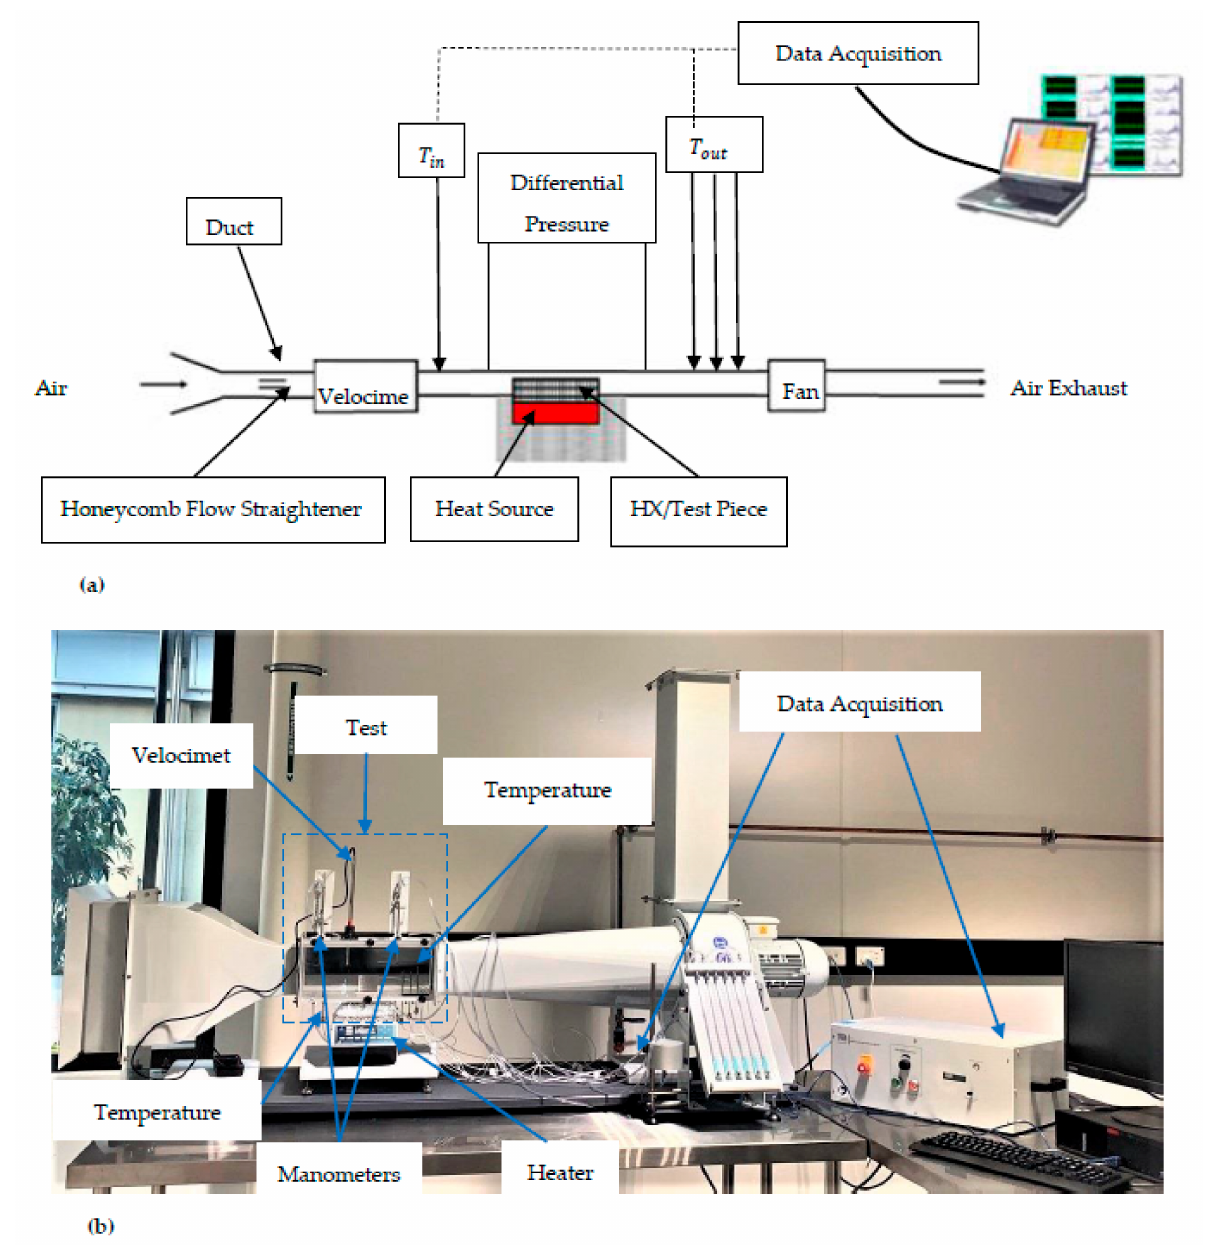
Figure 3. Test rig: ( a ) schematic and ( b )